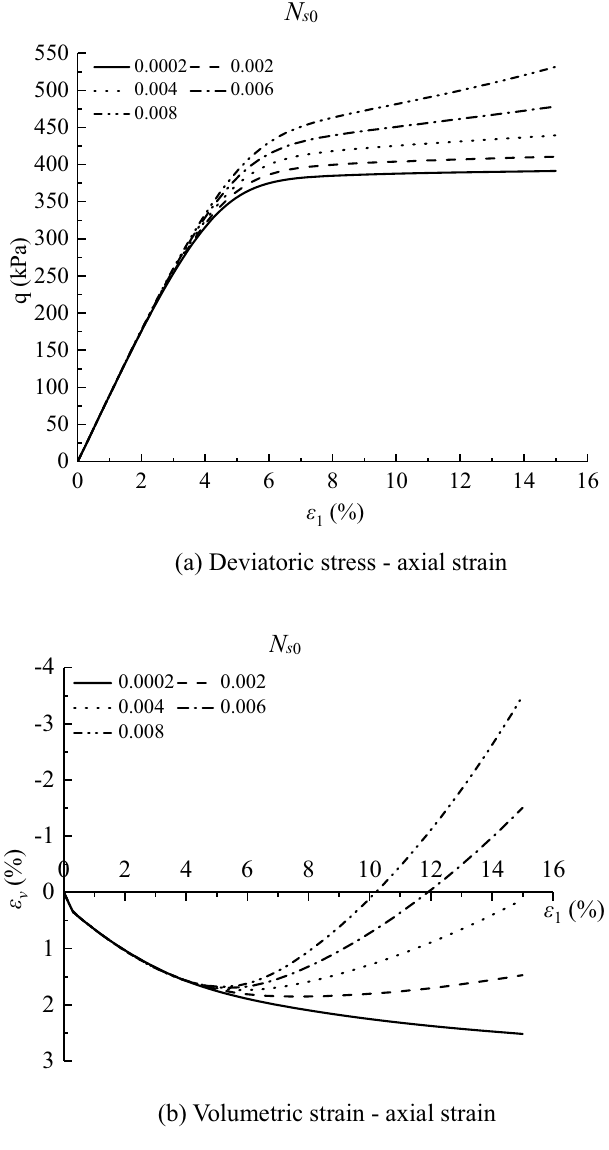
Figure 17. Sensitivity analysis of simulation results with varying N s 0